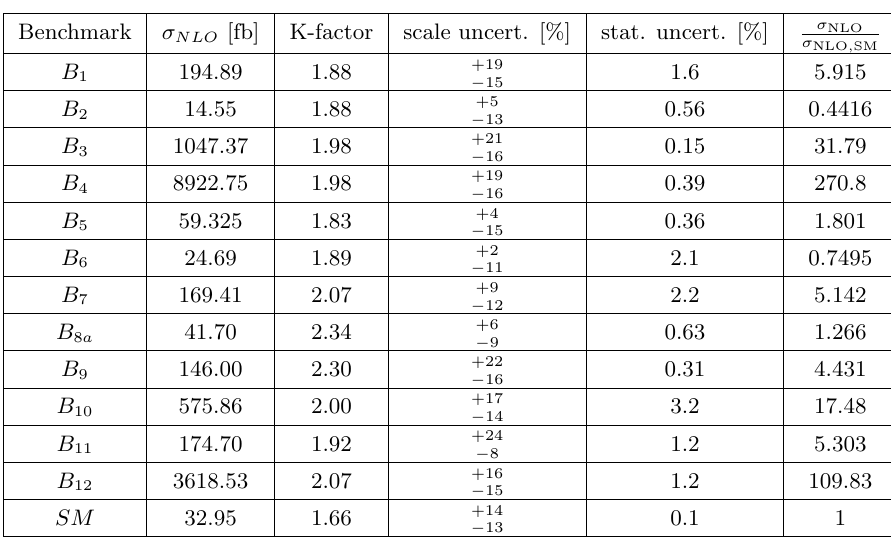
Table 4. Total cross sections at NLO (second column) including the K-factor (third column), scale uncertainties (4th column) and statistical uncertainties (5th column) and the ratio to the SM total NLO cross section (6th column).